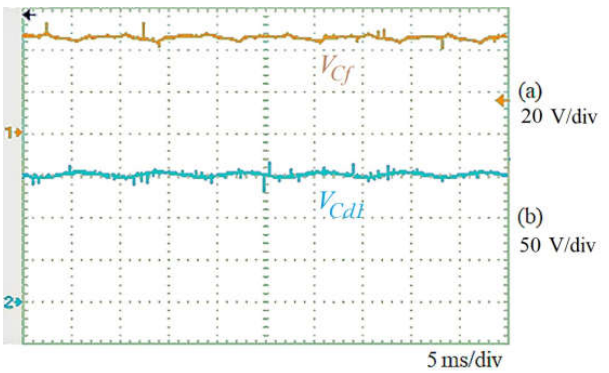
Figure 16. Experimental results for the DC side of the CC: ( a ) DC port voltage of FBC; ( b ) input voltage of the buck converter.